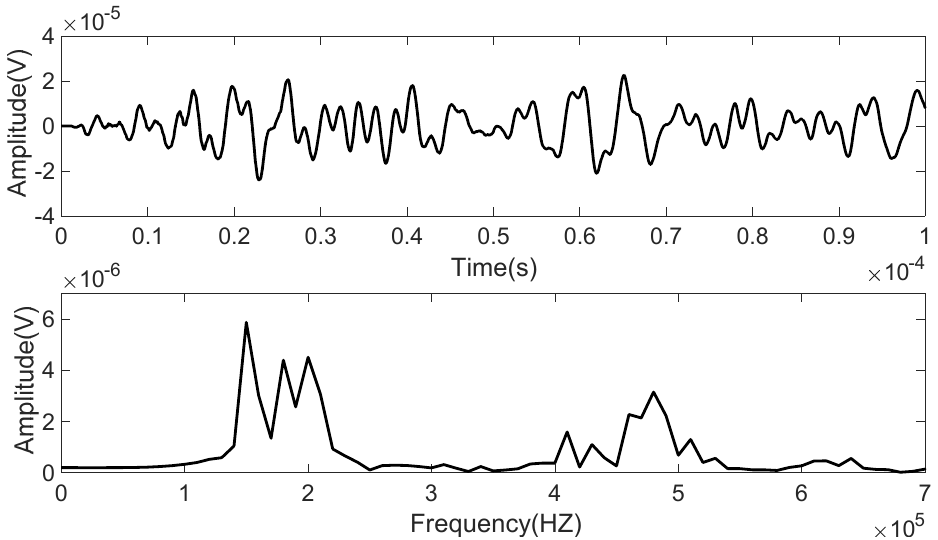
Figure 16. Simulated signal spectrum at different crack widths.